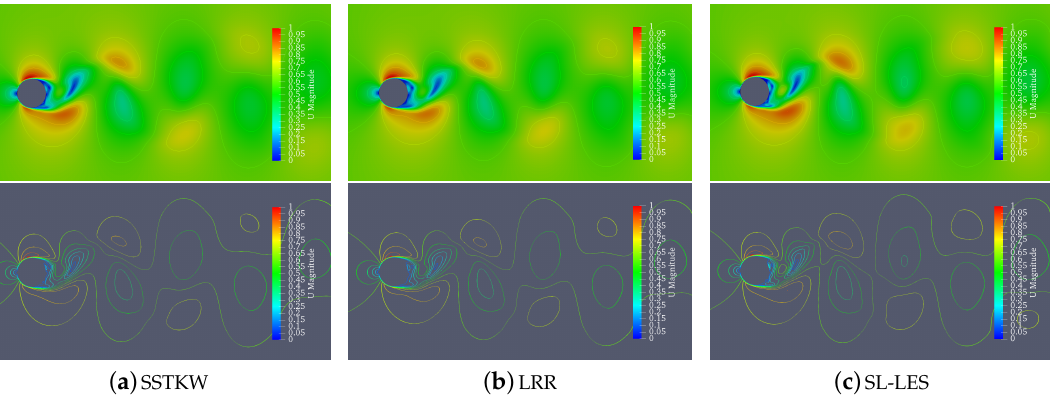
Figure 5. The wake morphology (velocity contour map) of the ( a ) SSTKW model, ( b ) LRR model, and ( c ) Smagorinsky–Lilly SGS model-based LES (SL-LES) model at the moment when the wake vortex is about to drop off the cylinder simulated by PRTFOAM. It shows that the results of the three models all produce obvious vortex street behind the cylinder, with only slight differences in wake morphology. Moreover, SL-LES model is better at capturing small vortices.